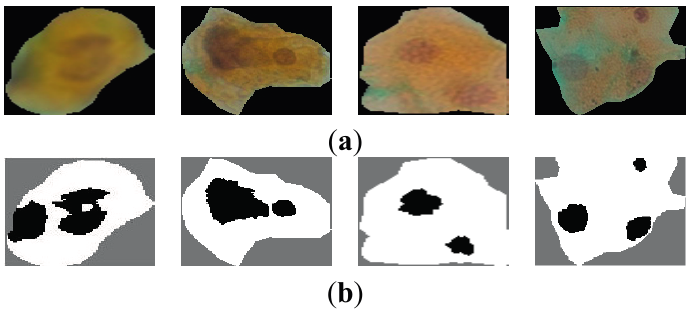
Figure 2. Samples of sputum cells through different mean shift segmentation stages. ( a ) sputum cells; ( b ) conversion to gray level and apply histogram equalization; ( c ) mean shift segmentation; ( d ) mode merging and region refinement.